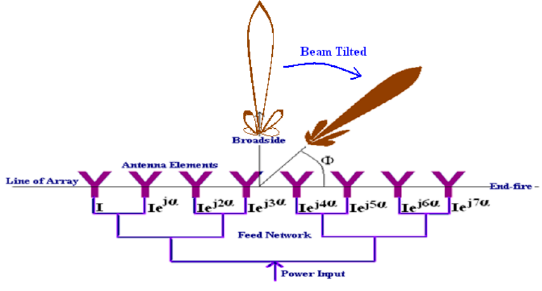
Figure 4. Beam steering/scanning antenna array [24].